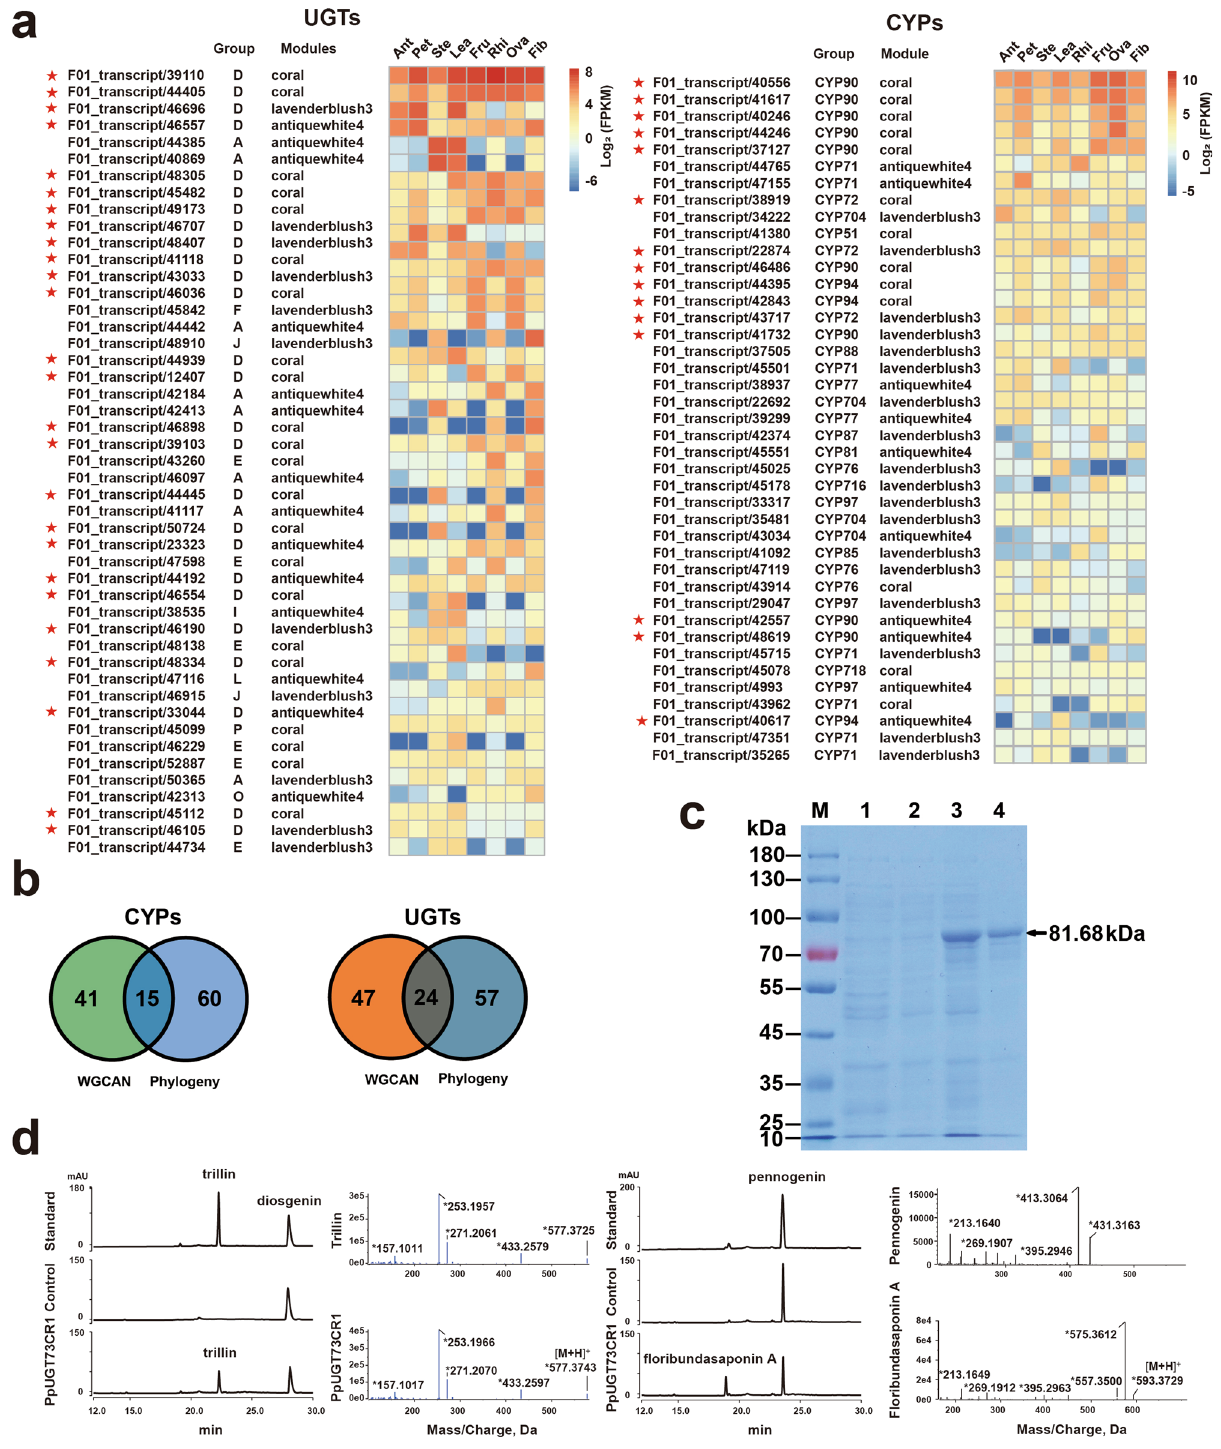
Fig. 4 Candidate CYP and UGT genes and gene function veri fi cation. a Heatmaps of the expression levels of candidate CYPs and UGTs in different tissues of P. polyphylla var . yunnanensis . All genes are arranged from top to bottom according to the total expression level. The asterisks represent key genes predicted by the evolutionary tree, WGCAN and gene expression. b Venn diagrams of candidate genes. Phylogenetic tree and WGCAN methods were used to predict candidate CYPs and UGTs, among which 15 and 20 CYPs and UGTs could be predicted by the two methods, respectively. c SDS – PAGE analysis of expressed PpUGT73CR1 protein. Lanes : M, protein molecular weight marker (Thermo Fisher); 1, pGEX-6p-1 vector transformed in E. coli Rosetta (DE3) cells with IPTG induction; 2, pGEX- UGT73CR1 vector transformed in E. coli Rosetta (DE3) cells without IPTG induction; 3, pGEX- UGT73CR1 vector transformed in E. coli Rosetta (DE3) cells with IPTG induction; 4, the puri fi ed recombinant protein of PpUGT73CR1. d Functional veri fi cation of PpUGT73CR1 gene. The functional veri fi cation of candidate UGTs was performed by HPLC and LC-TOF-MS, and the enzyme encoded by PpUGT73CR1 gene could introduce the glucose group into C-3 of diosgenin and pannogenin.